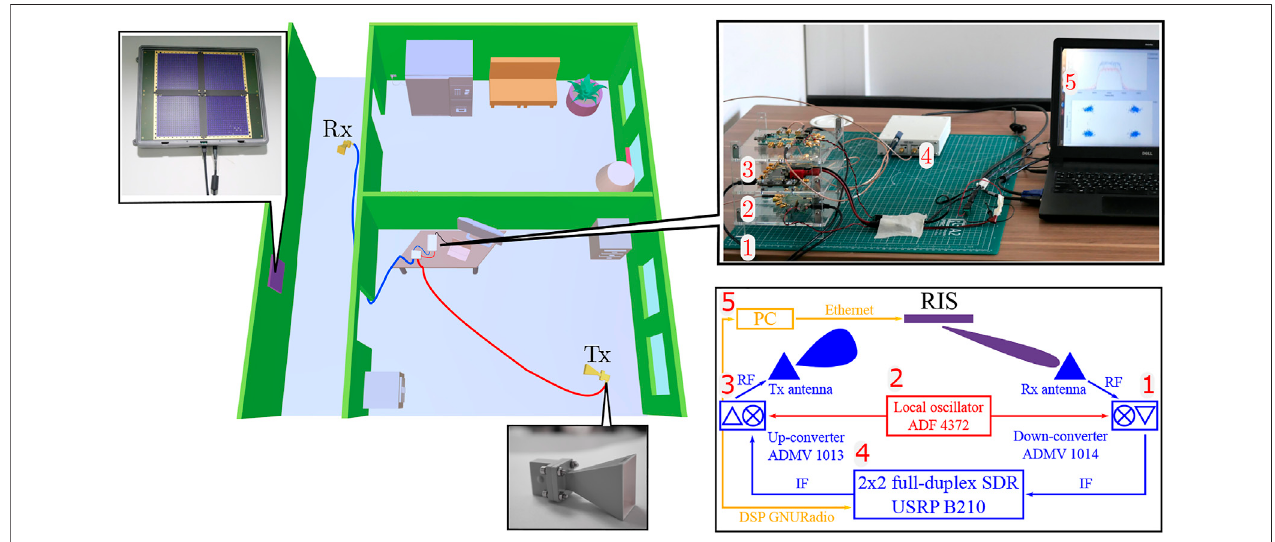
FIGURE 3 | Left: A 3D illustration of the experimental setup used to demonstrate RIS-aided indoor wireless communication in a NLOS situation. Right: A photography (top panel) and a schematic (bottom panel) of the communication module represented by a down-converter 1 , a local oscillator 2 , an up-converter 3 , a SDR 4 , a PC 5